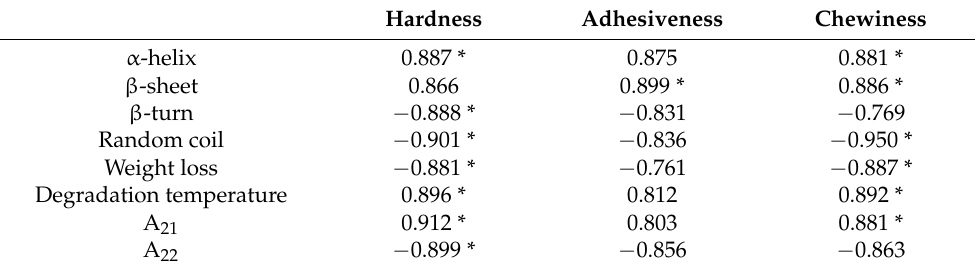
Table 4. Pearson’s correlation analysis between texture, structural characteristics and moisture morphology of TF, SA, GG and XG noodles. Hardness Adhesiveness Chewiness α -helix